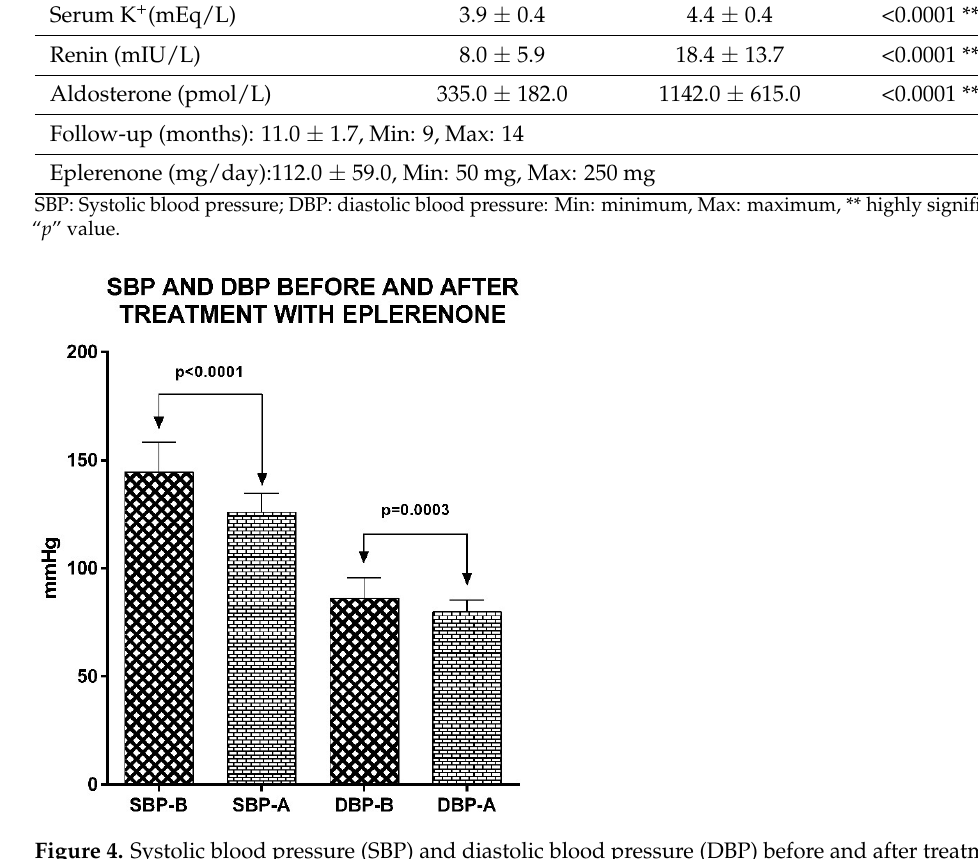
Table 4. Clinical and biochemical assessment of HDM-2 patients with PA before and after treatment with eplerenone. Before Treatment After Treatment